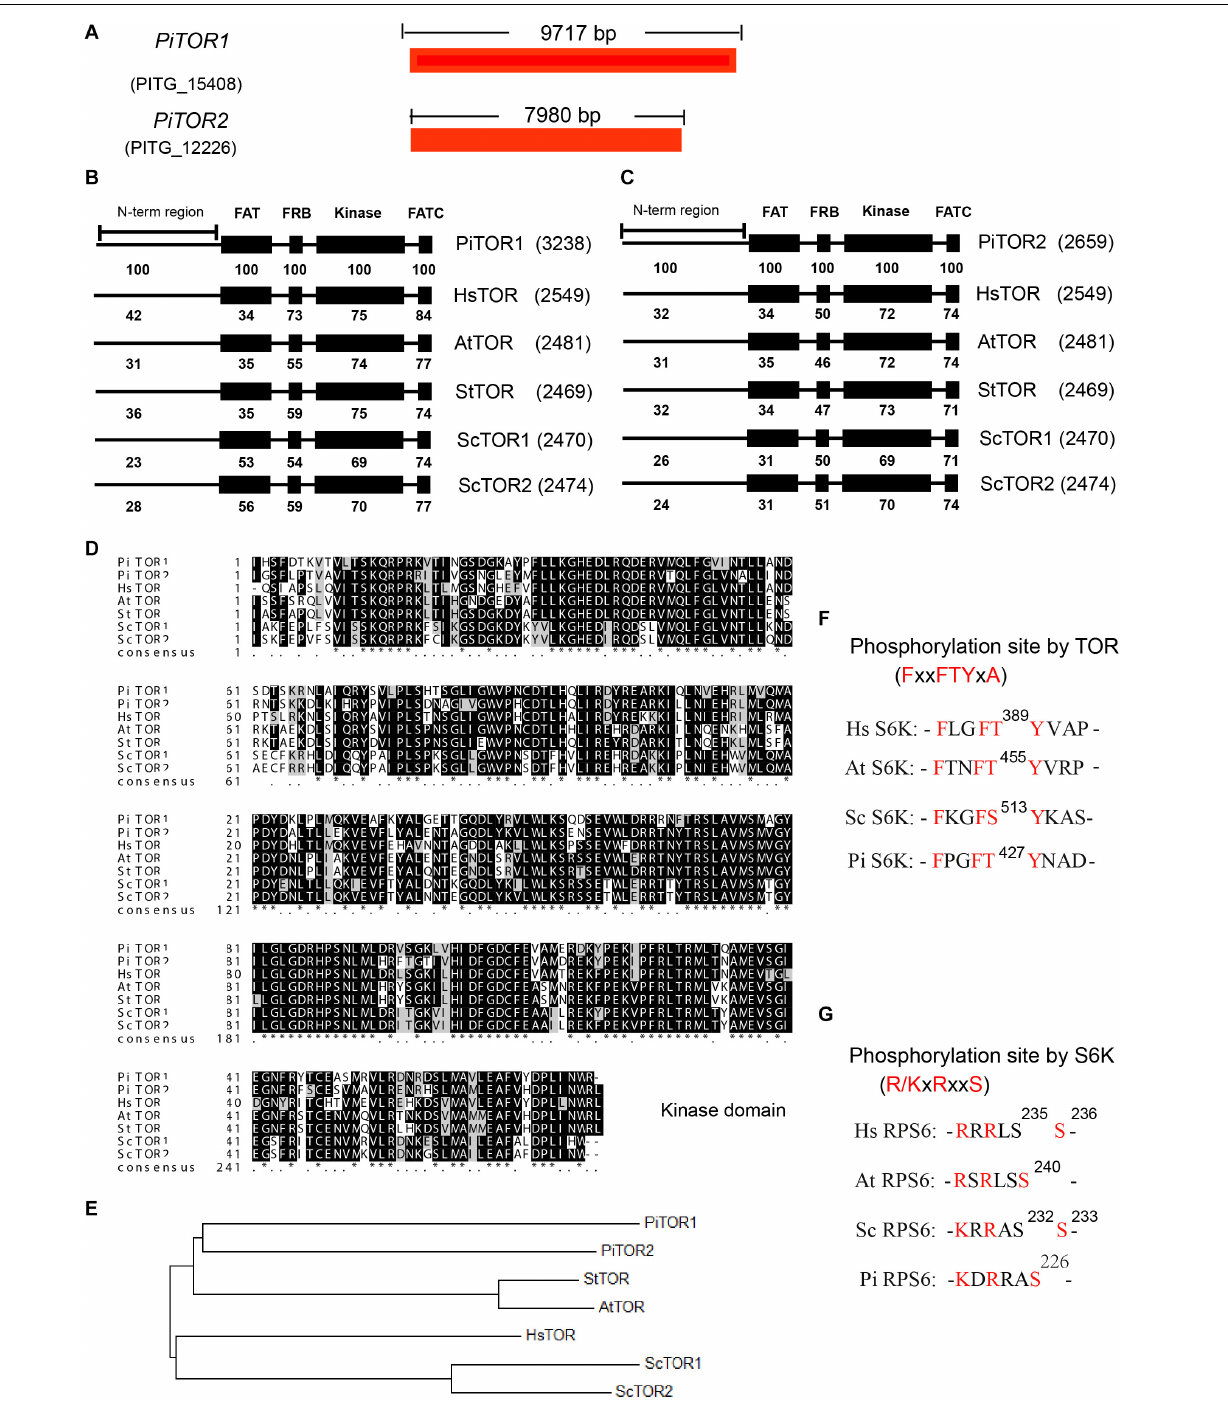
Frontiers in Microbiology |